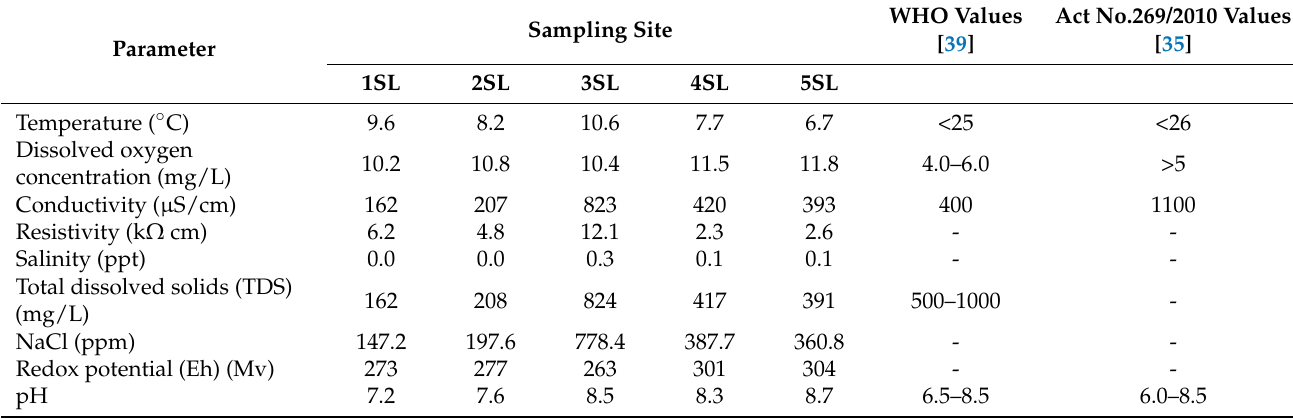
Table 2. The measured values of physicochemical parameters in the water samples of the Slovinsk ý creek (Slovakia).